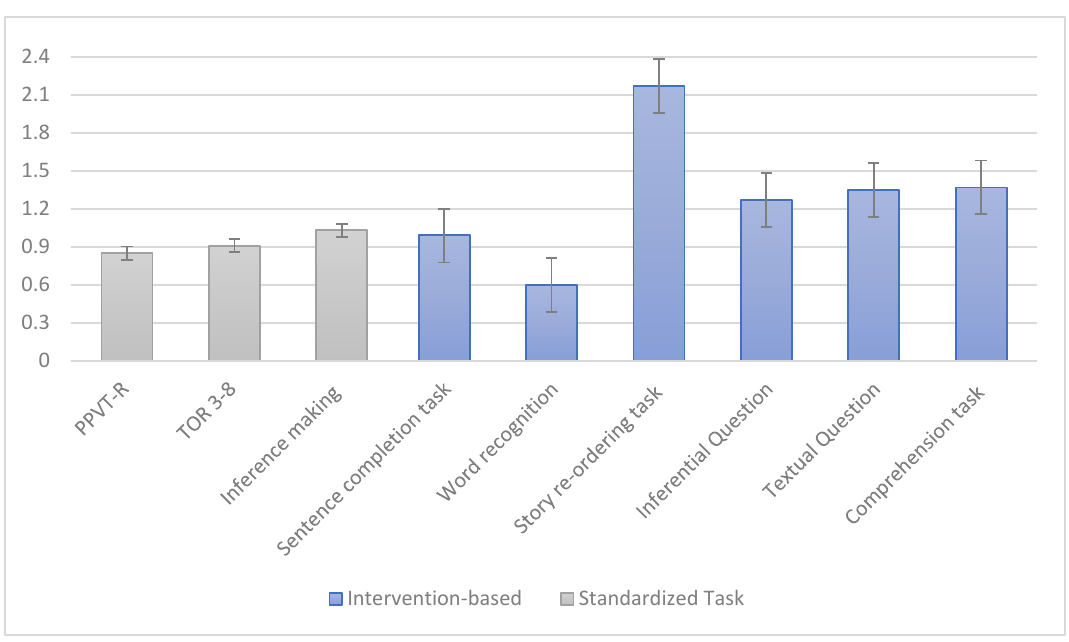
Figure 1. Standardized intervention gains for differences between pre-test and post-test.